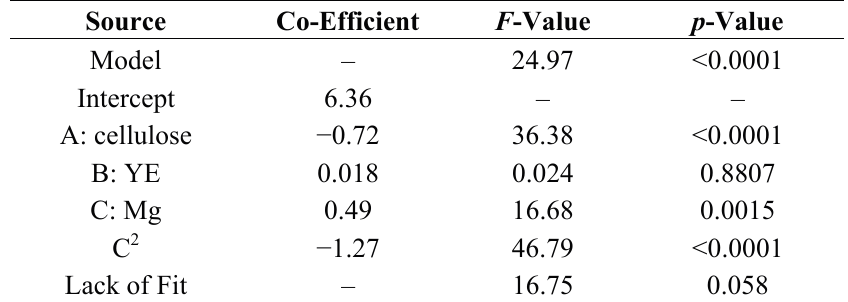
Table 5. Reduced quadratic model obtained for the specific productivity of H 2 . Model co-efficients are presented in terms of coded factors.